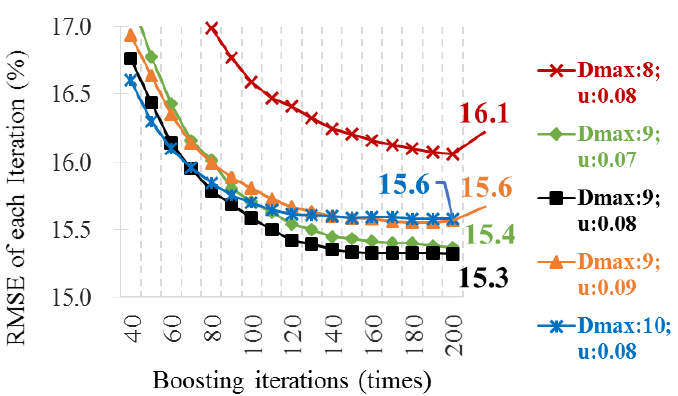
Figure 6. Variation of RMSE with iteration number as a function of maximum tree depth and learning rate.